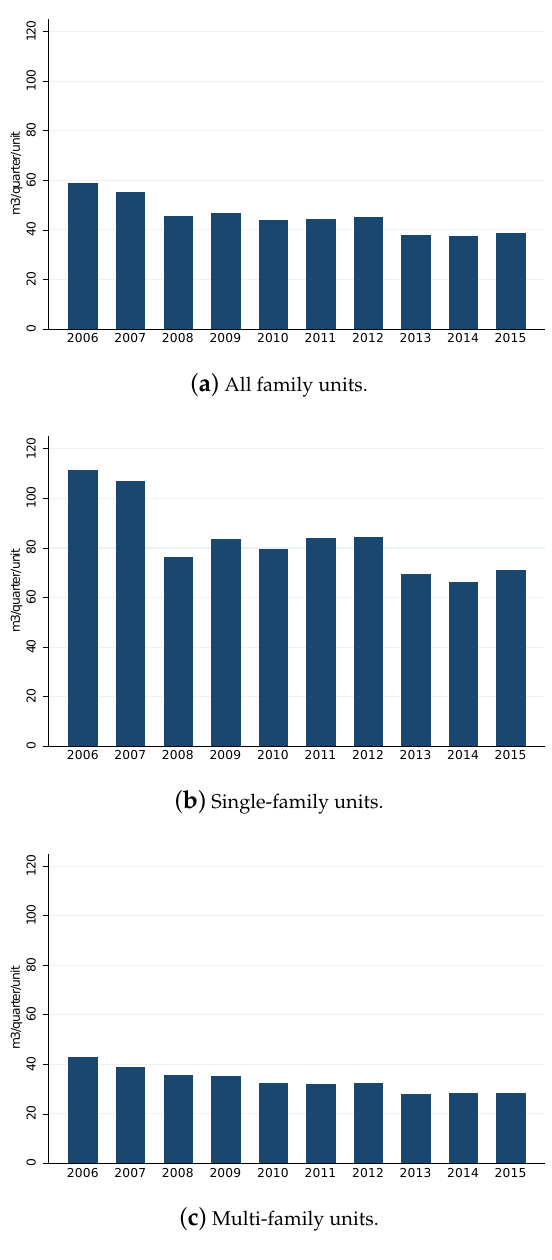
Figure 1. Average quarterly water consumption by type of family unit (m 3